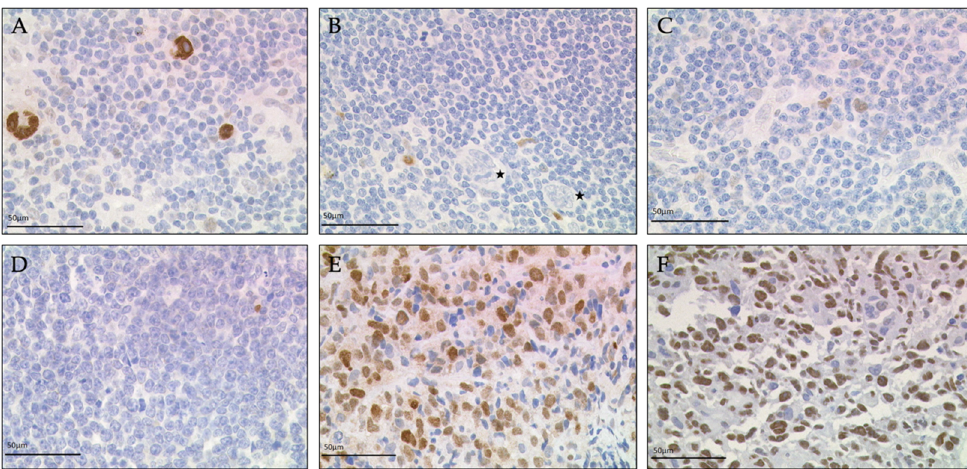
Figure 1. Characterization of BATF3-expression in tumor cells of classical Hodgkin lymphoma (cHL), nodular lymphocyte predominant Hodgkin lymphoma (NLPHL) and Non-Hodgkin lymphoma (NHL). Strong BATF3 expression in Hodgkin/Reed-Sternberg (HRS) cells of cHL ( A ). No BATF3 expression in lymphocyte predominant cells (asterisks) of NLPHL ( B ) and in tumor cells of follicular lymphoma (FL) ( C ) and Burkitt lymphoma (BL) ( D ). Tumor cells of primary mediastinal large B-cell lymphoma (PMBL) ( E ) showed moderate BATF3 expression, tumor cells of anaplastic large cell lymphoma (ALCL) show strong BATF3 expression ( F ). Calculated BATF3-scores were 300 ( A , F ), 180 ( E ) and 0 ( B – D